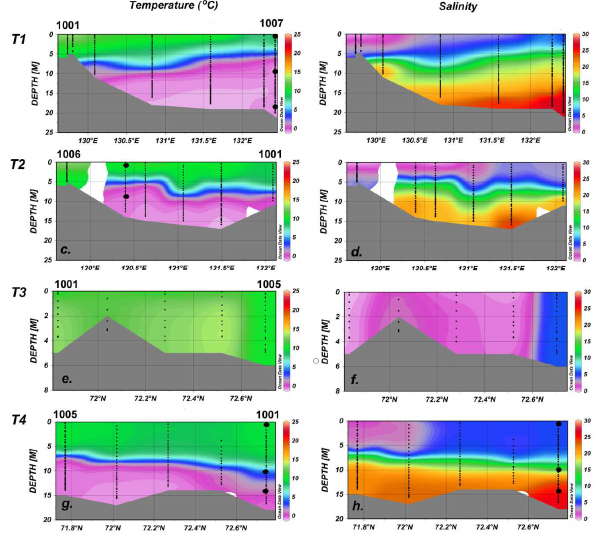
Fig. 3. Salinity and temperature profiles for the four coastal tran- sects: (a) = transect 1, (b) = transect 2, (c) = transect 3, (d) = tran- sect 4. The larger circles indicate examples of sampling locations in relation to the thermocline in stratified water columns. Samples were taken from surface waters and above/below the thermocline.